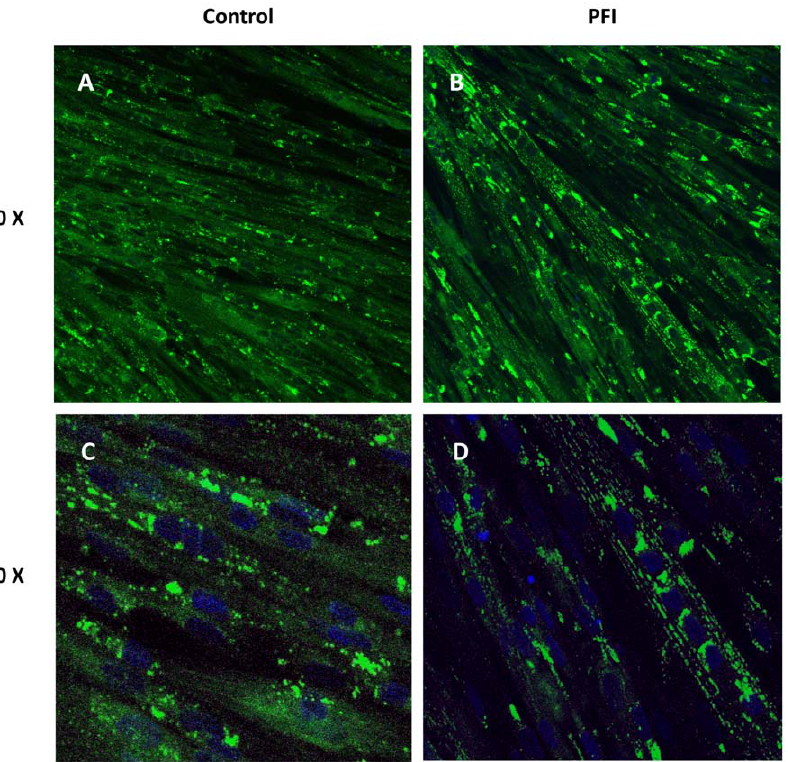
Figure 3. Confocal microscopy of lipid droplets. Lipid droplets were stained with Bodipy 493/503 (green) and nuclei were stained with DAPI (blue). Note the increase in the organization of lipid droplets along the myofibrillar apparatus in panels B (20 6 ) and D (40 6 ) upon PFI treatment.